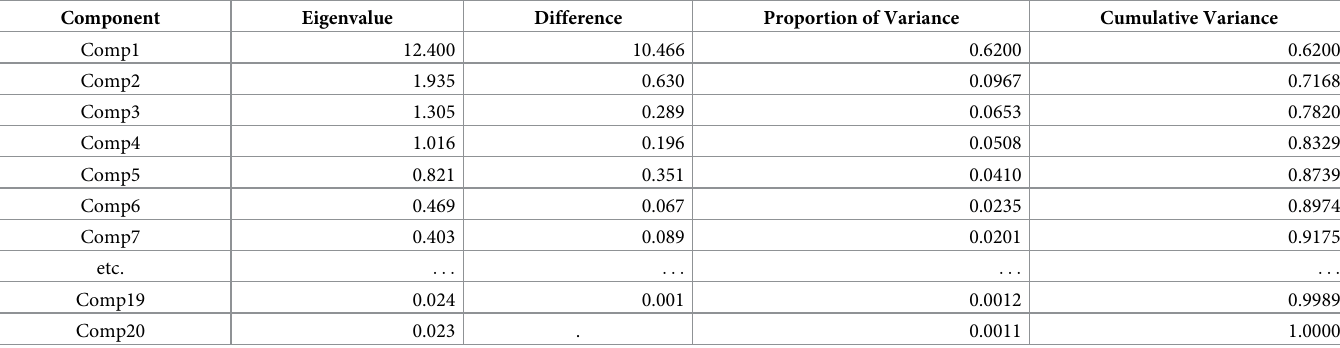
Table 3. Identification of principal